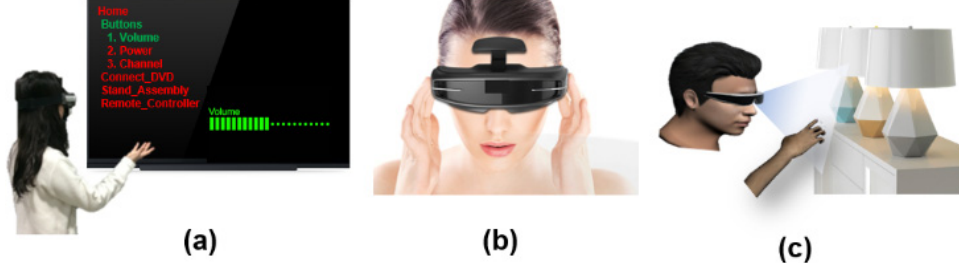
Figure 12. Different styles of AR interaction using object type and requirements. Such information is obtained directly from the object, similar to the case of tracking information: ( a ) natural gesture used to carry over a task such as controlling TV volume; ( b ) swiping interaction for an AR manual searching task; ( c ) pointing gesture for toggle interaction, such as operating a lamp’s on/off switch.